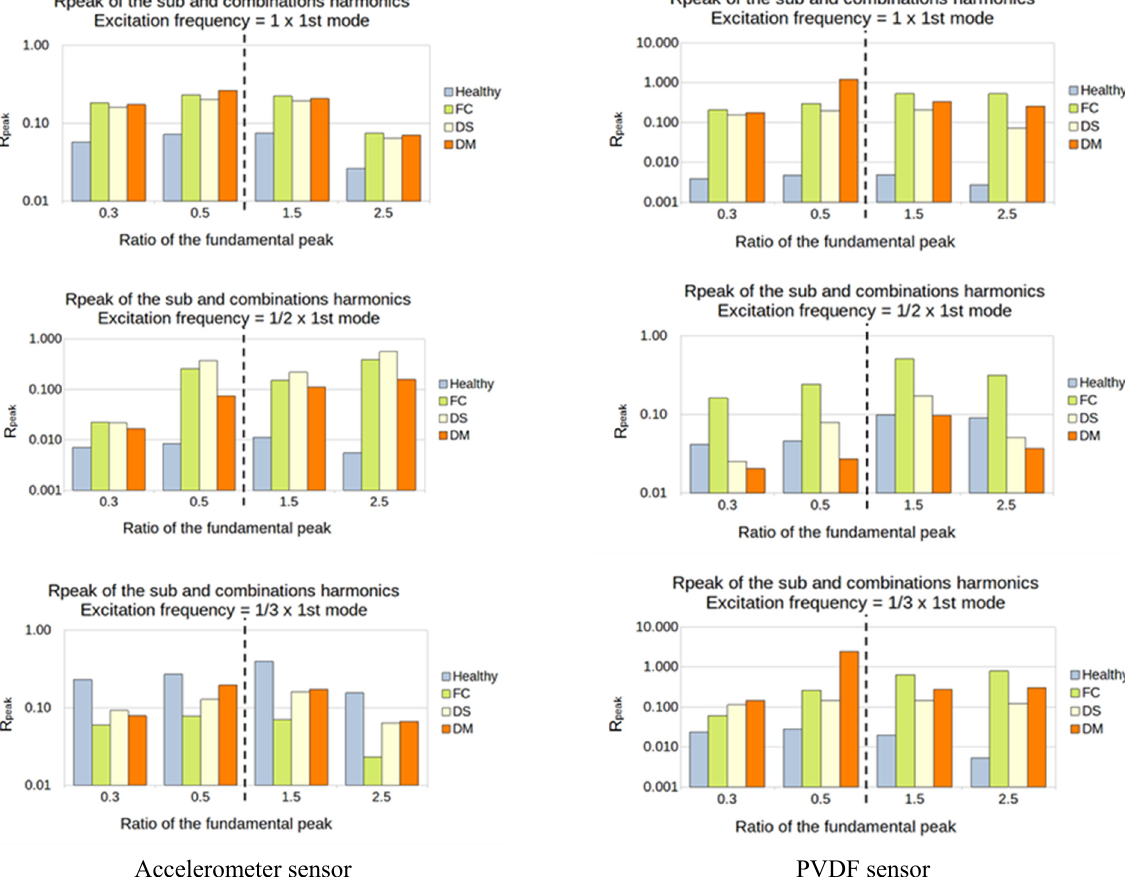
Figure 16. First natural frequency and its ratio of 1, 1/2, and 1/3 as the frequency of excitation. For the second natural frequency, the difference between healthy and damaged plates is smaller; indeed, only the FC plate showed a high sensitivity in almost all the cases. Another interesting thing is that the super-harmonics of 1.5 and 2.5 provide good results for the excitation frequencies of 1/2 and 1/3 for both sensors. No interesting results came out from the ratio of 1 (Figure 17).